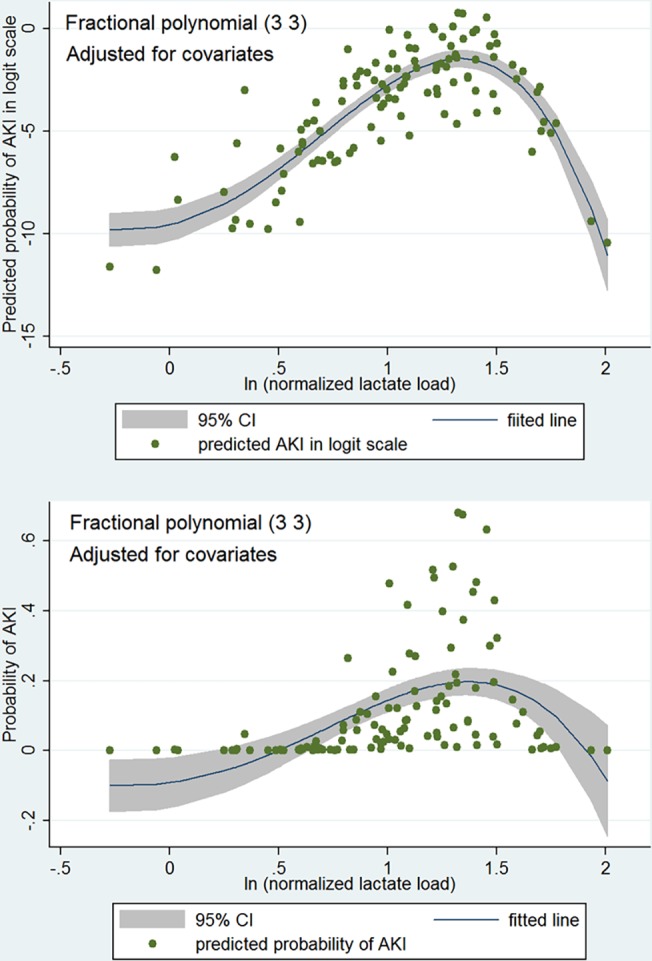
Graphical presentation of the fitted two-term (3 3) fractional polynomial logistic regression model.In the upper panel, the y-axis is in logit scale with the advantage of better distribution for model fit. Y-axis is transformed to the probability of AKI in lower panel which is more comprehensible to subject matter audience. The plots show that the probability of AKI increases progressively with increasing normalized lactate load, reaching its peak at Lln≈1.4.